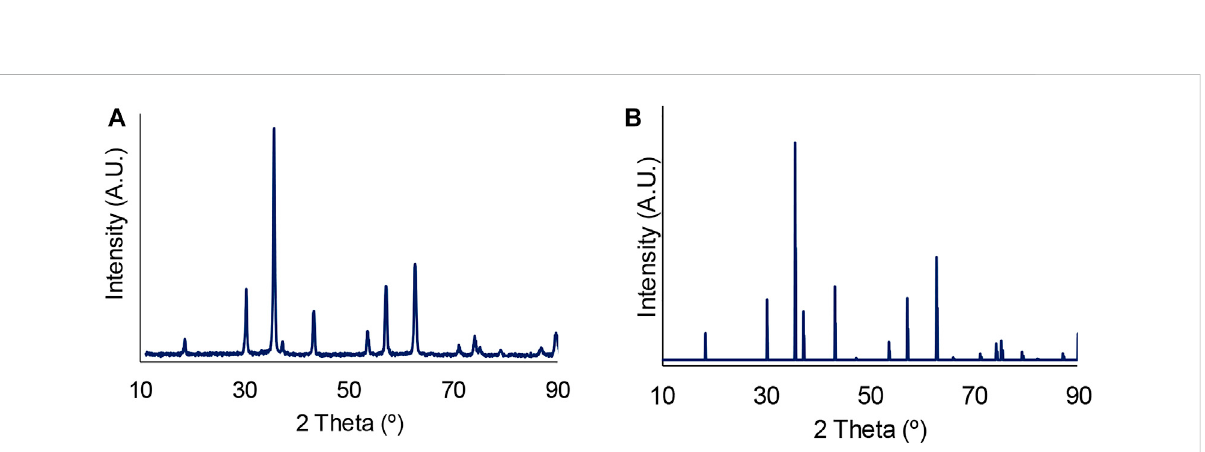
FIGURE 7 (A) XRD pattern for spent Fe 3 O 4 after 120 h of reaction time; (B) Reference XRD pattern for Fe 3 O 4 from RRUFF database, RRUFF id R061111.2 (RRUFF,